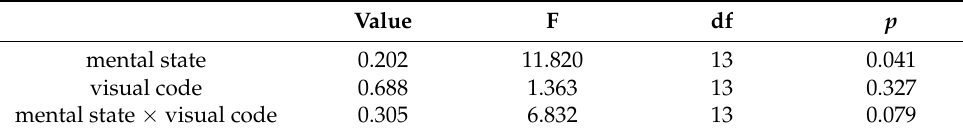
Table 7. Multivariate ANOVA results for P200 latency of mental state and visual